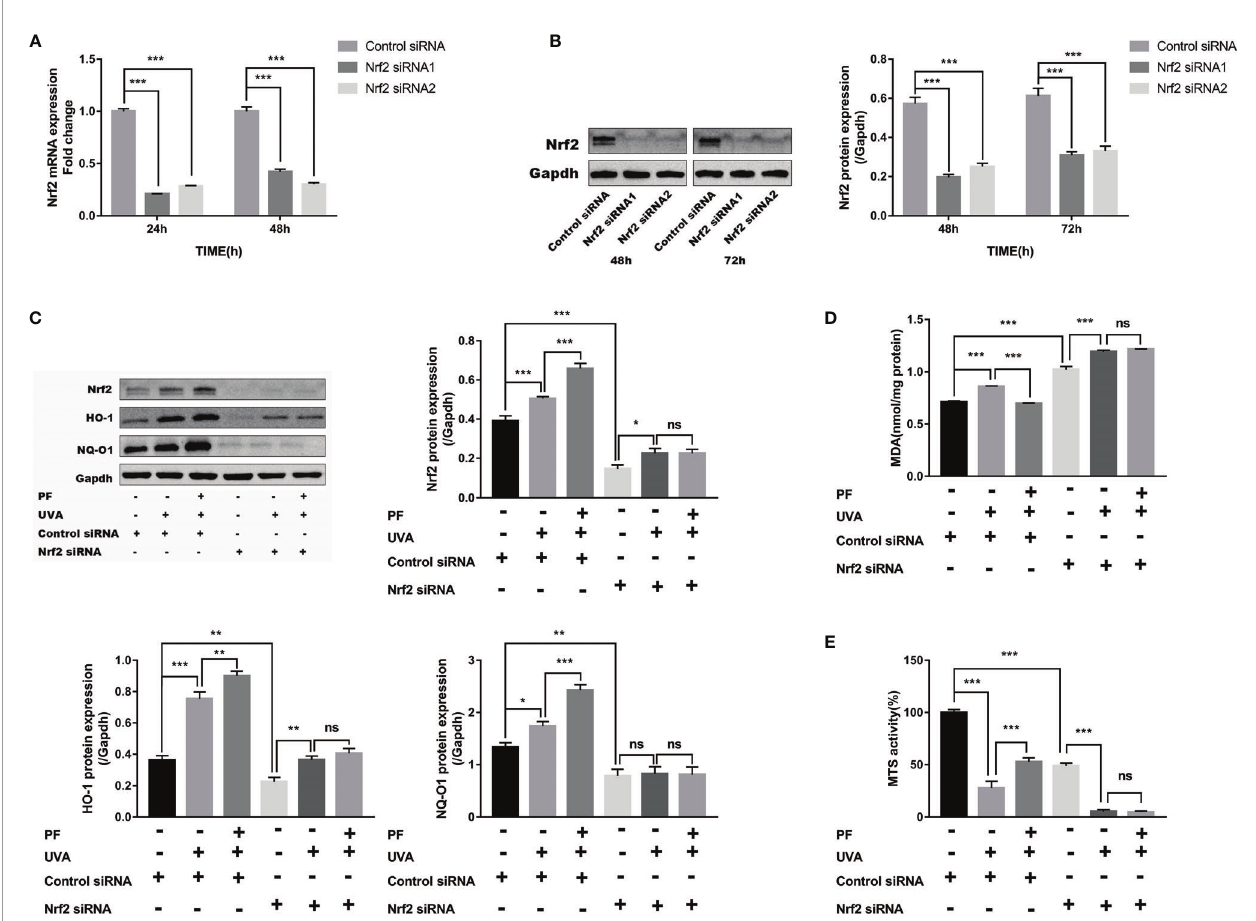
FIGURE 3 | PF inhibited UVA-induced oxidative stress and cytotoxicity via Nrf2. (A) The mRNA levels of Nrf2 in fi broblasts at 24 and 48 h of transfection. The relative expression level of Nrf2 in each group was normalized to the control group. (B) The protein levels of Nrf2 in fi broblasts at 48 and 72 h of transfection, the representative result of western blot and the quantitative analyses of three independent experiments were shown. (C) Western blot detection of the protein levels of Nrf2, HO-1, and NQ-O1 after UVA and PF-pretreatment in absent of Nrf2, the representative result of western blot and the quantitative analyses of three independent experiments were shown. (D) Detection of MDA level in fi broblasts treated with UVA radiation and PF in absence of Nrf2. (E) The MTS activity of fi broblasts with UVA radiation and PF-pretreatment in absence of Nrf2. All data were expressed as the mean ± standard deviation according to at least three independent experiments. * p < 0.05, ** p < 0.01, *** p < 0.001, ns p >